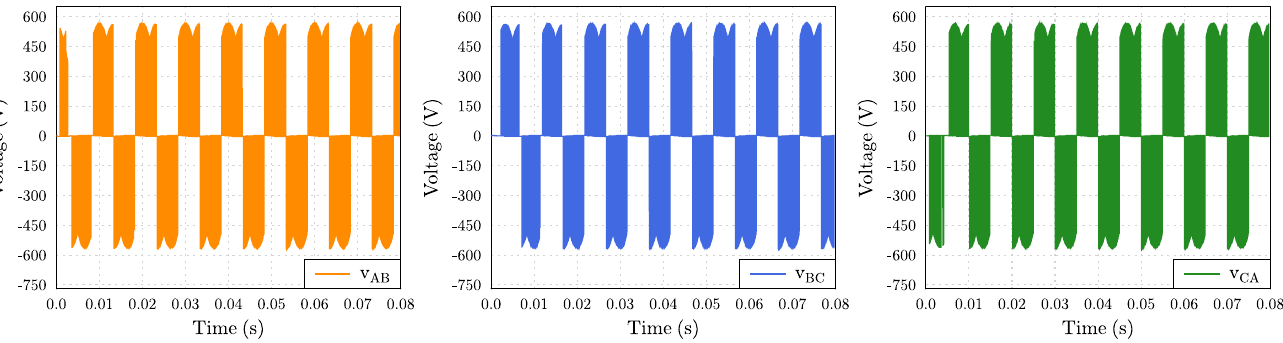
Figure 16. Output line voltages of the DMC controlled by SVM.